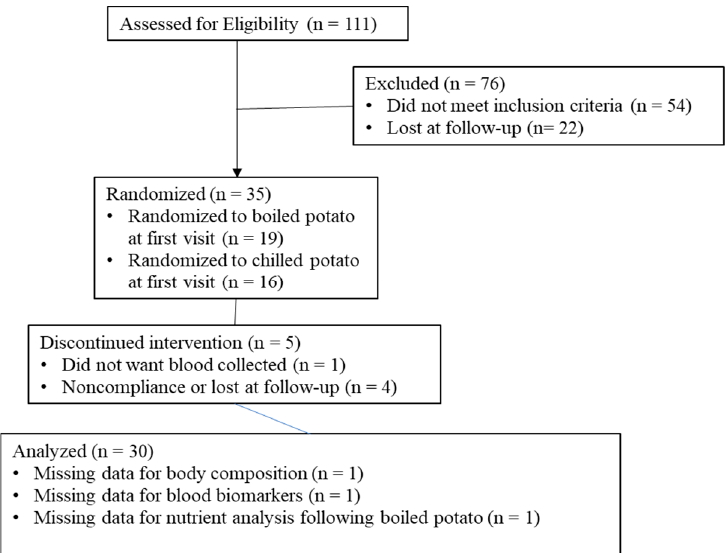
Figure 1. Subject flow through the study protocol.